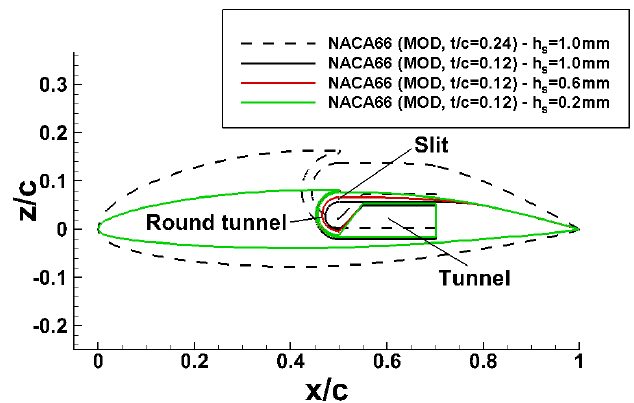
Figure 21. NACA66 (MOD, t/c = 0.12) geometry for each slit height.